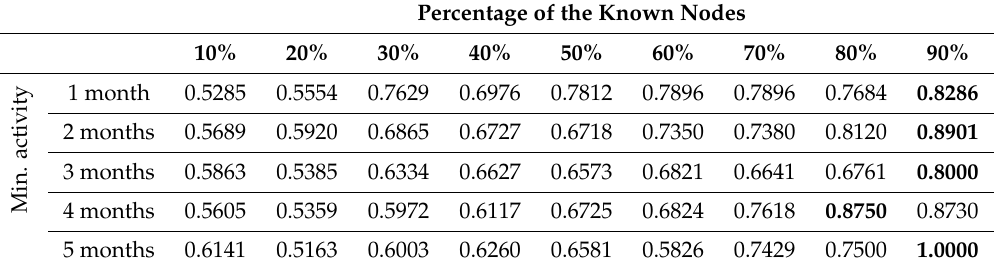
Table A15. F-score macro average for the collective classification of two levels of the hierarchy in the Enron dataset. The values which are bolded are the best results for a given minimum communication